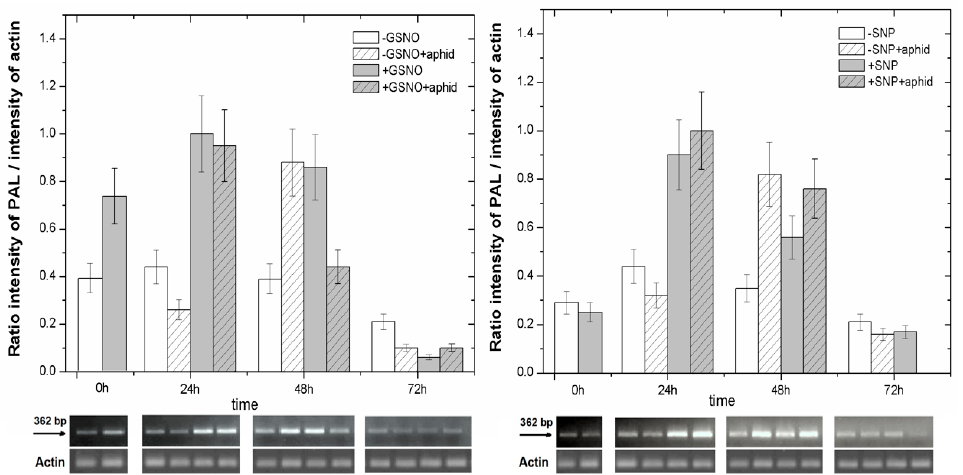
Figure 4. RT-PCR products amplified from the PAL genes obtained from pea seedling leaves pretreated with NO donors (GSNO or SNP) or non-pretreated, both in the non-infested and infested by A. pisum , constitutive actin expression and a ratio of intensity of PAL/intensity of actin. The data were obtained in three independent experiments and statistically analysed using ANOVA ( p -values at α < 0.05). Hypotheses on the equality of means were verified by the two-sample t -test (Table S2). To account for multiple testing, we used the Bonferroni correction.